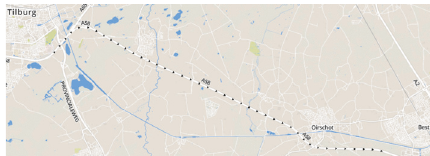
Figure 3: A58 test route running from Tilburg to Eindhoven, covering 19 km.